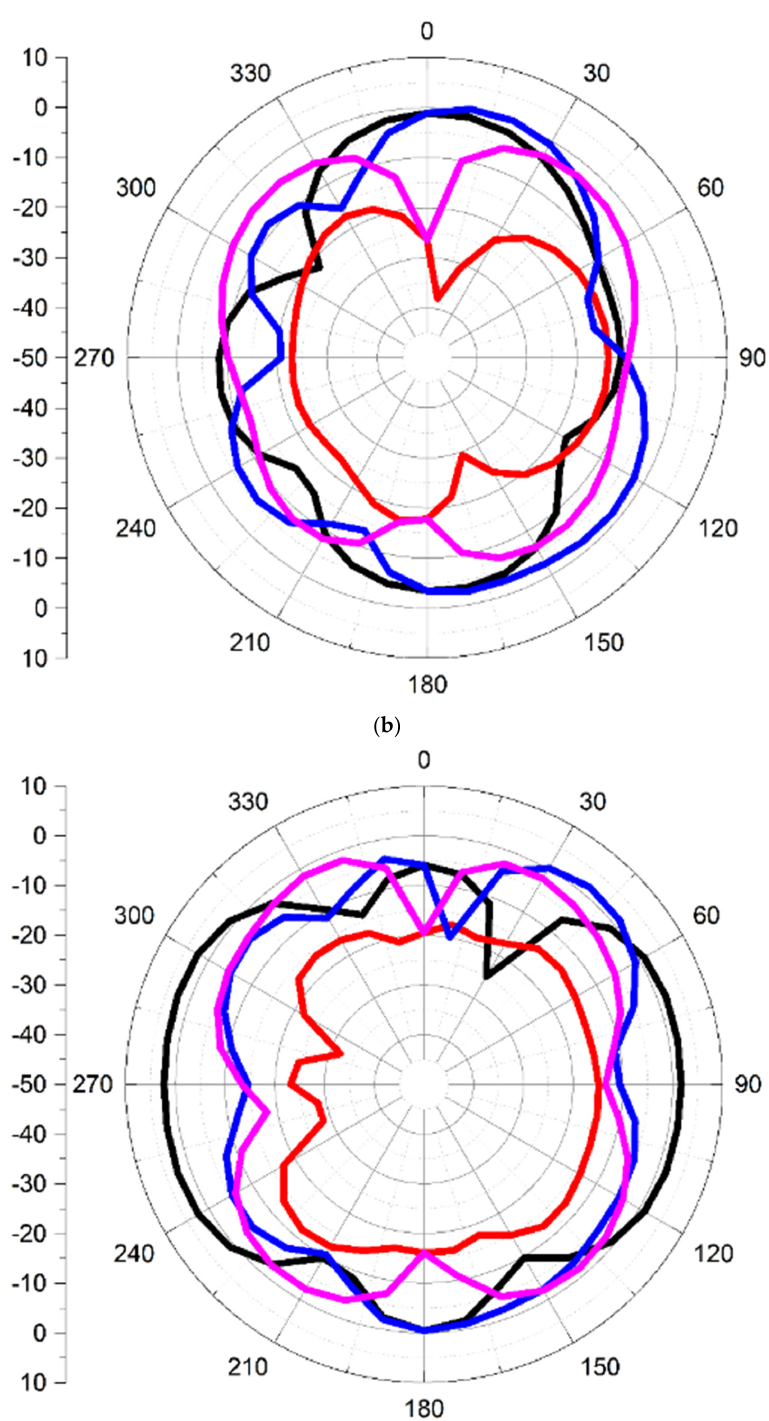
Figure 12. The simulated radiation pattern of the UWB antenna at ( a ) 3.6 GHz, ( b ) 6.8 GHz, and ( c ) 9.7 GHz .